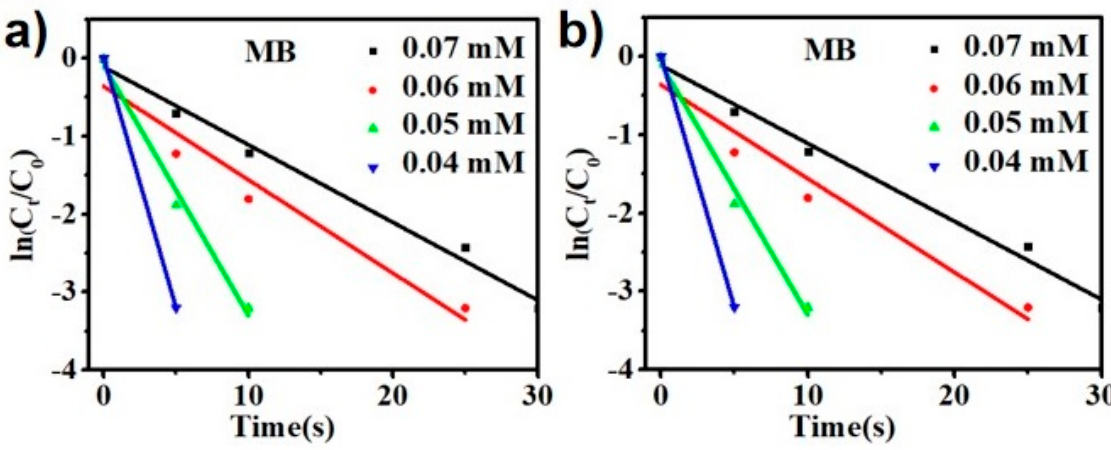
Figure 4. ( a , b ) Pseudo-first-order kinetic linear simulation curves for MB catalytic degradation